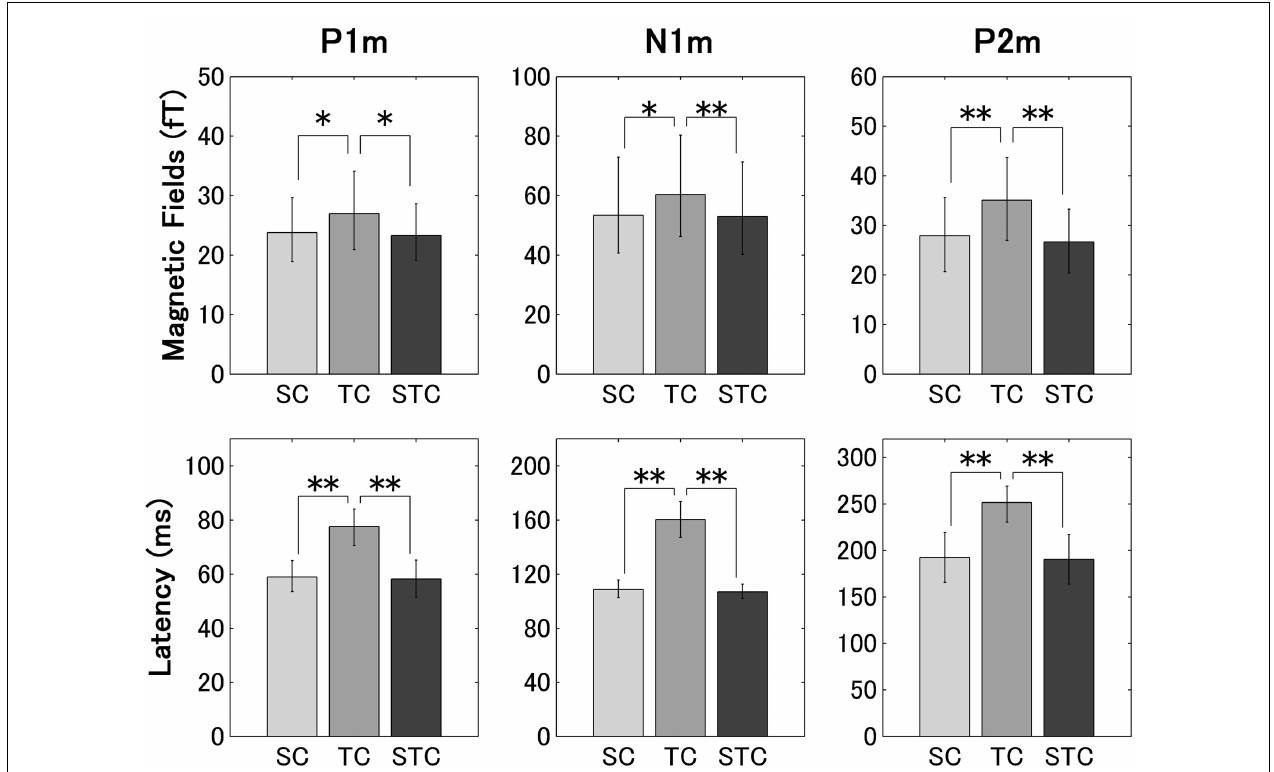
FIGURE 8 |The group means ( N = 14) of the P1m, N1m, and P2m RMS amplitudes and latencies in experiment 2 (arrangements according to Figure